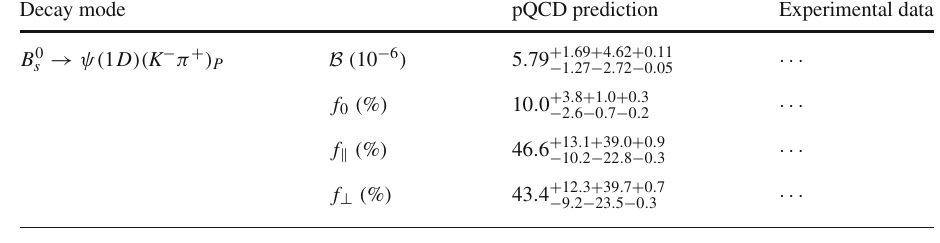
Table 5 Branching ratios of the D-wave resonance in the quasi-two-body decays B 0 s →